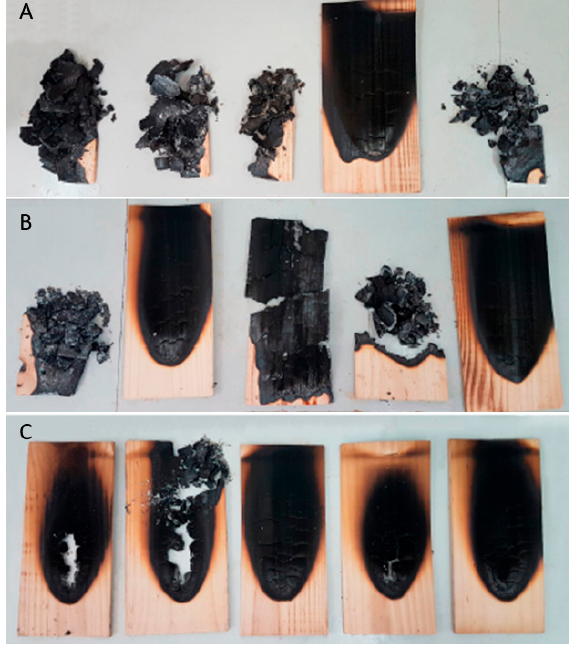
Figure 7. Wood samples after the fire-resistance test. ( A ) control samples; ( B ) samples treated with the fire-retardant agent AF7000; ( C ) CaCO 3 mineralized samples.